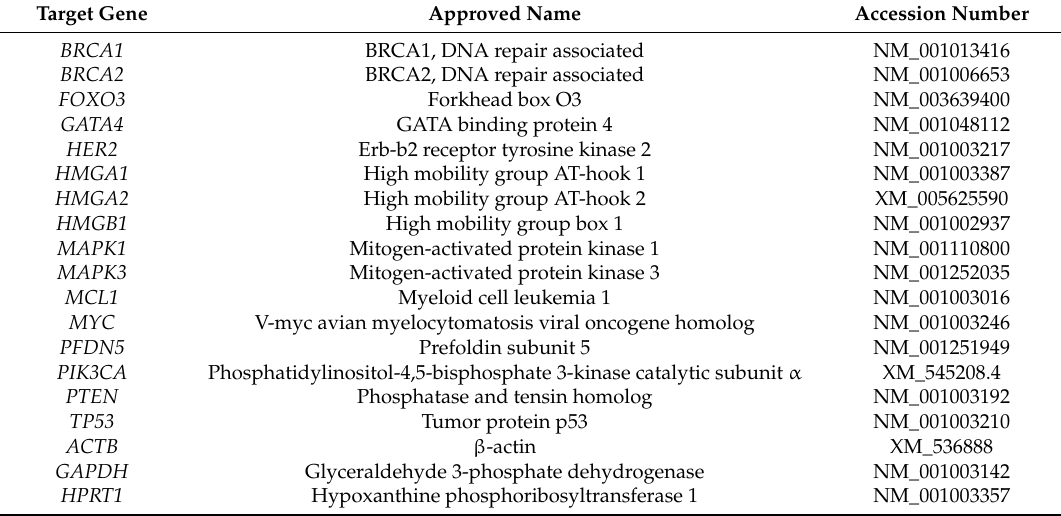
Table 4. Target and housekeeping genes with their approved name and respective accession